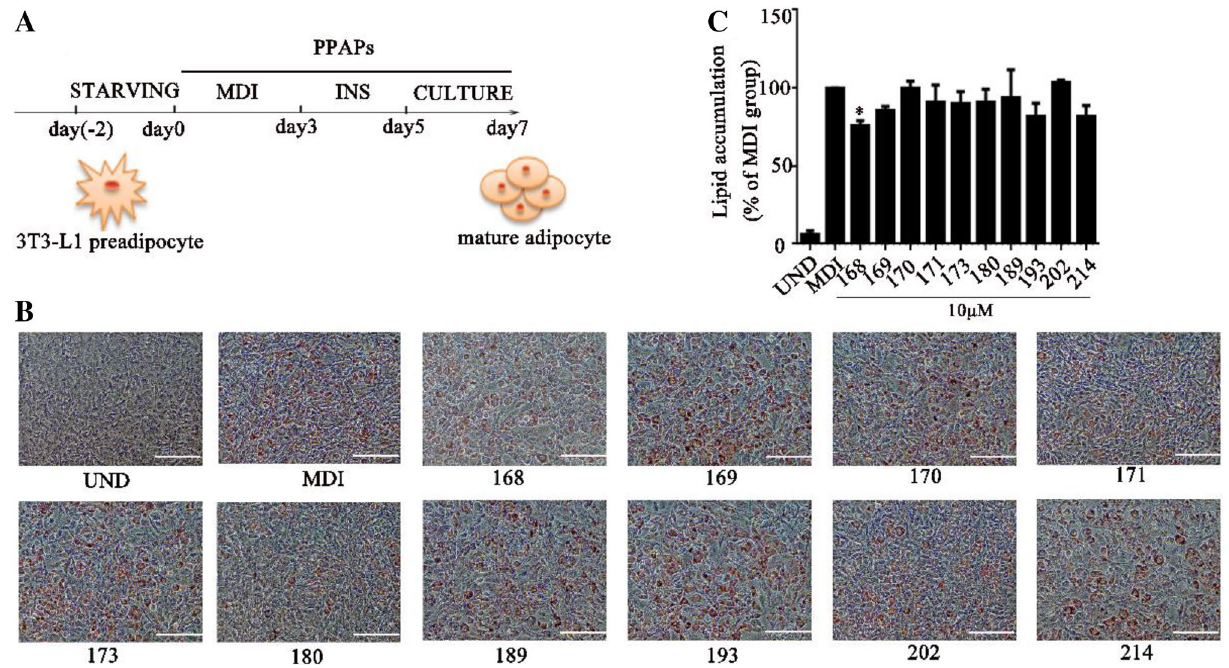
Fig. 1 Screening of PPAPs in regulating of adipocyte differentiation. a Schematic diagram of inducing 3T3-L1 adipocyte differentiation. b Representative images of the cells treated with ten of PPAPs (10 µM) and stained by Oil Red O. Scale bars, 100 µM. c Normalized lipid